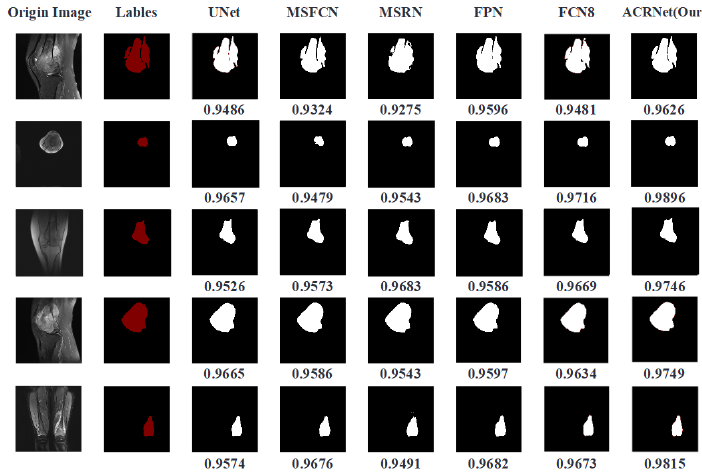
Figure 6. Comparison of segmentation results of each model on different images.